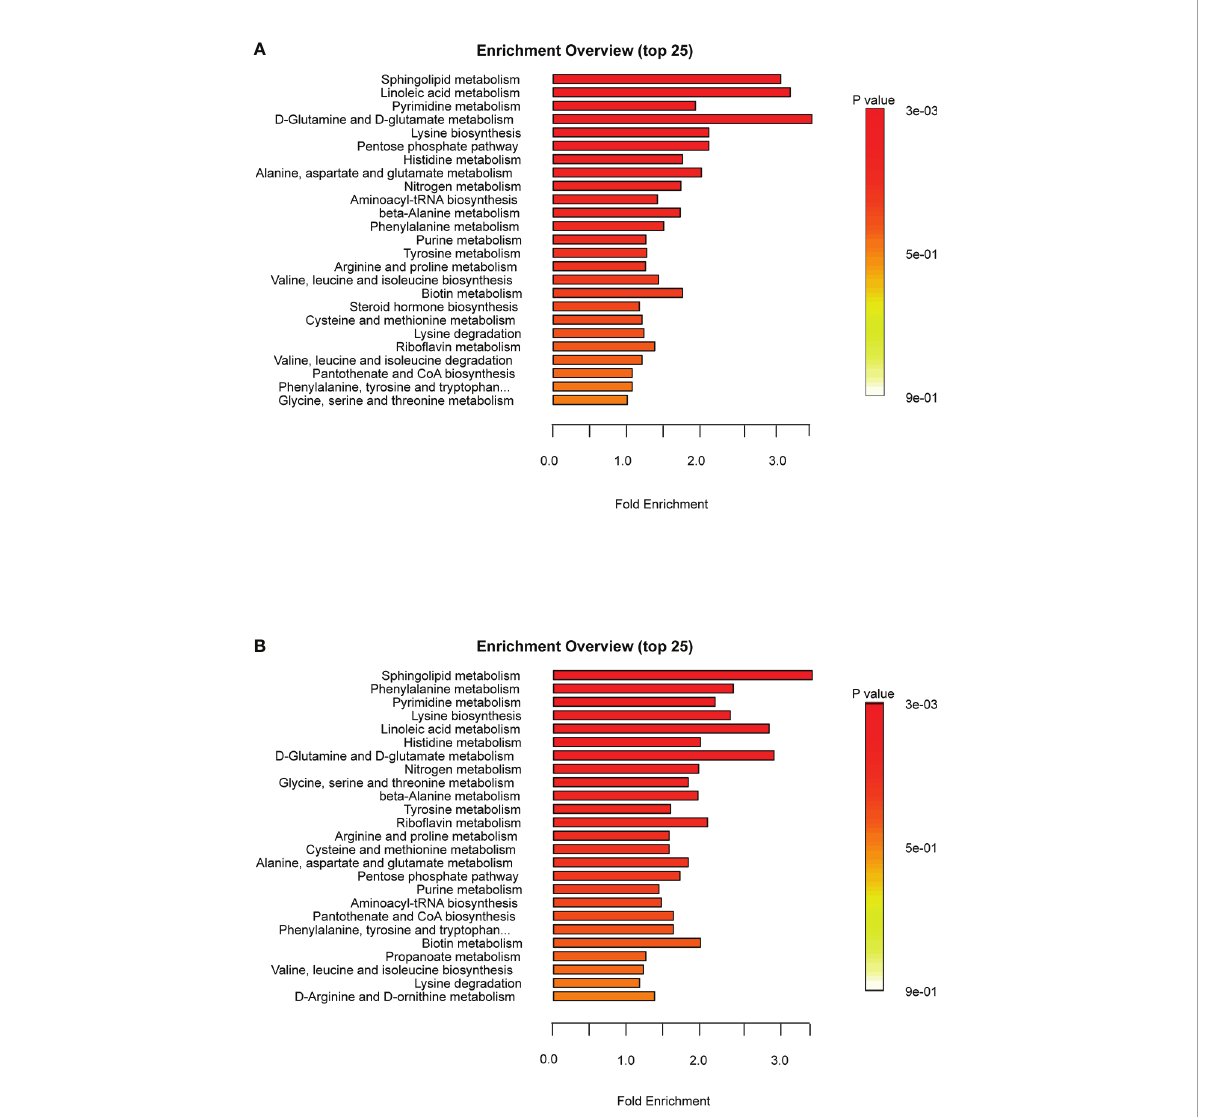
FIGURE 5 Metabolic pathways analysis of A . japonicus intestines in the comparisons of DA vs. NA (A) and AA vs. DA (B)